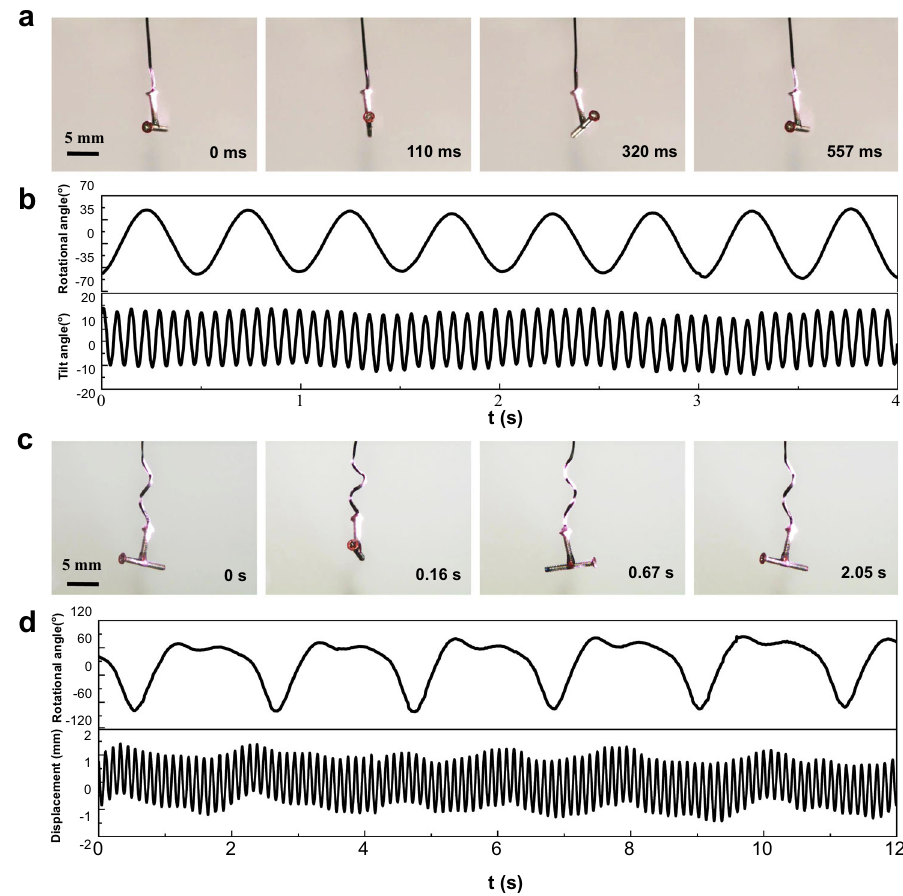
Fig. 4 Complex self-oscillations. a , b Snapshots exhibiting a complex oscillation that combines rotational oscillation and tilt oscillation (Supplementary Movie 9), and the corresponding oscillation dynamics. To gain this complex oscillation, the connection part between the hanging object and the SWFA must be irradiated. c , d Snapshots exhibiting a complex oscillation that combines rotational oscillation and up-and-down oscillation (Supplementary Movie 10), and corresponding oscillation dynamics. The intensity of NIR light is ~4.5 W cm − 2